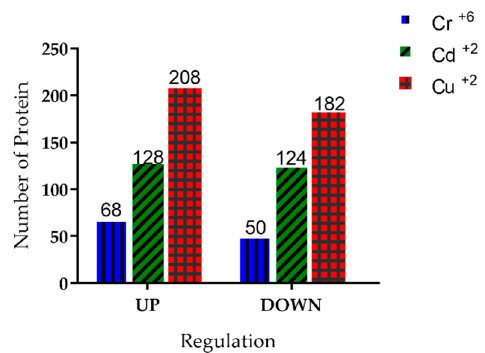
Figure 6. Proteins differentially regulated under treatment with Cr +6 , Cd +2 , and Cu +2 ions. A total of 118 proteins were differentially regulated in the presence of Cr 6+ , 252 in the presence of Cd +2 , and 390 in the presence of Cu +2 ions. The bars indicate the number of proteins identified under treatment with each metal. The changes in protein expression were relative to the control .